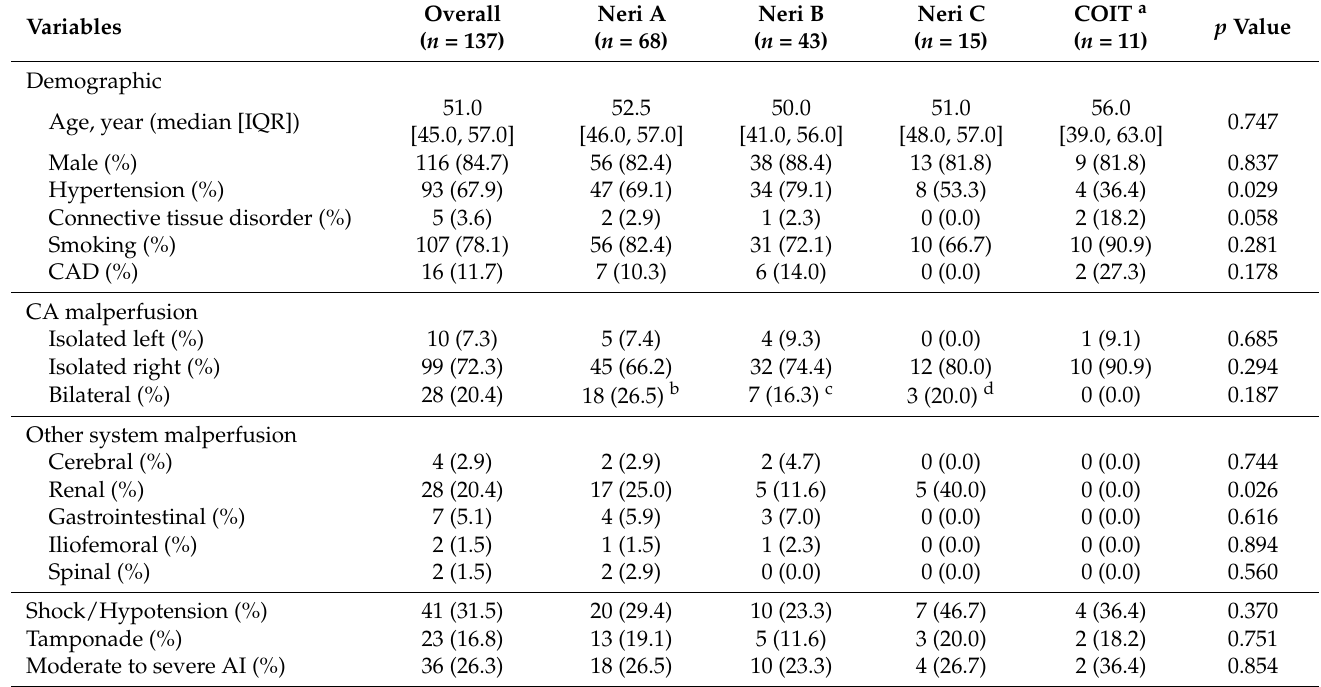
Table 4. Preoperative characteristics of patients with CM.